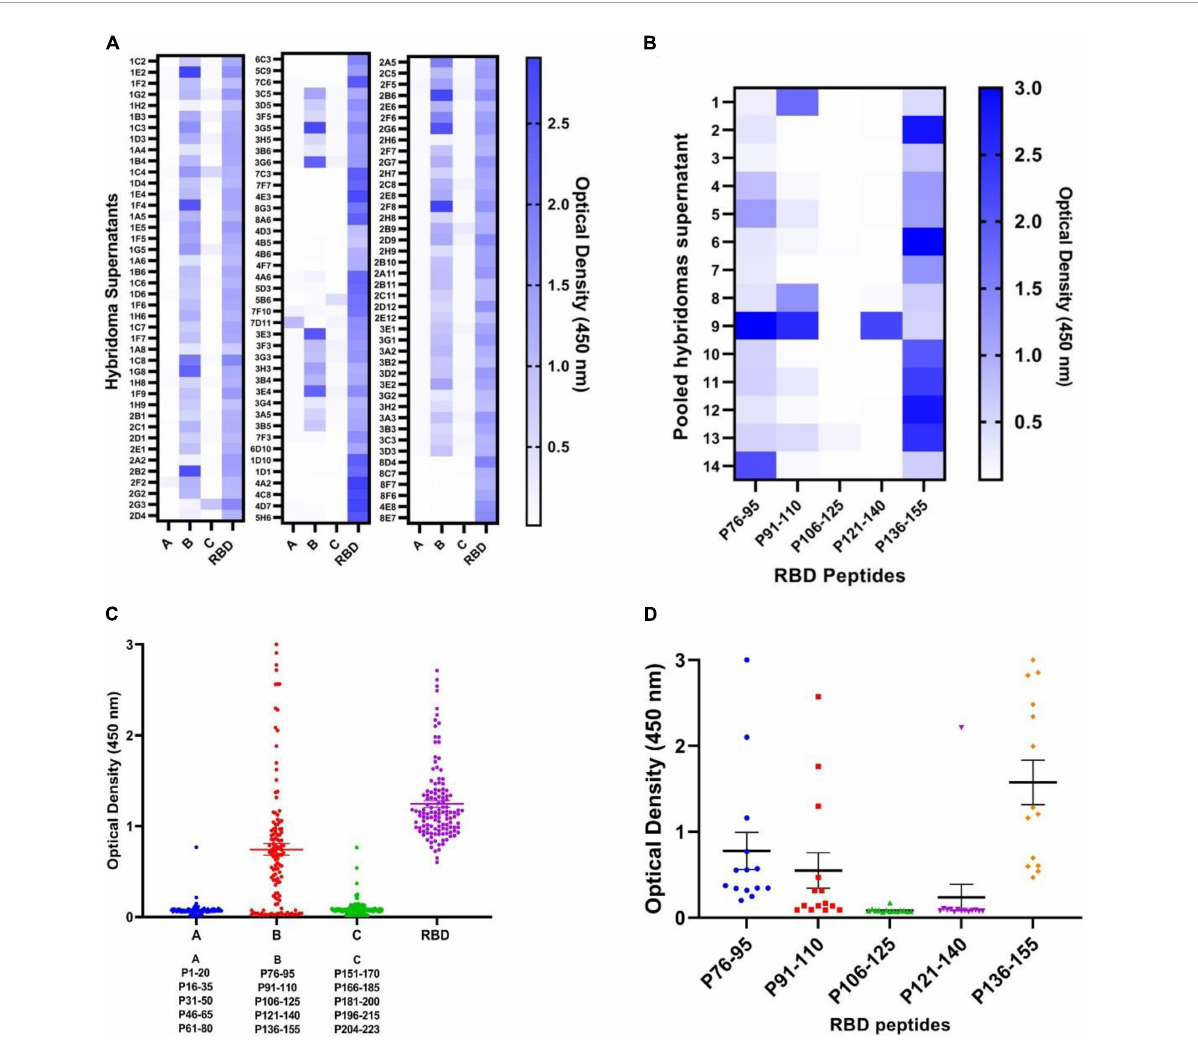
FIGURE3 Pepscan analysis of hybridoma supernatants by ELISA. (A,B) Mapping the immunodominant epitopes of the SARS-CoV-2 RBD protein by Pepscan analysis against hybridoma supernatants and identification of the immunodominant peptide pools. A total of 125 anti-RBD hybridoma supernatants were subjected to three pools (A–C) of overlapping peptides and RBD antigen by ELISA. Each pool contains five 20-mer overlapping peptides covering the entire RBD. Reactivities are presented as heatmap and dot plot. (C,D) Identification of the immunodominant epitope among “pool B” peptides from the RBD protein. Individual peptides (P76–95, P91–110, P106–125, P121–140, and P136–155) were screened with hybridoma supernatants to determine the most reactive peptide. Reactivities are presented in the heatmap and dot plot. The solid lines represent mean ± SD. ELISA, enzyme-linked immunosorbent assay; RBD, receptor binding domain; S, spike; SARS-CoV-2, severe acute respiratory syndrome coronavirus